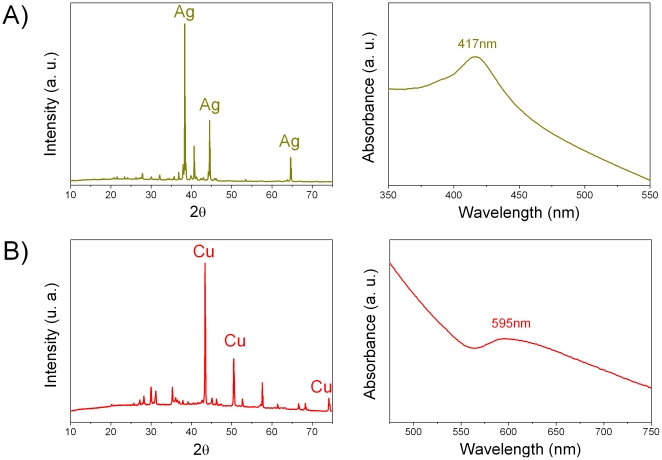
XRD patterns and UV-vis spectra corresponding to: A) n-Ag glass coating obtained at 740°C and B) n-Cu coating obtained at 850°C.